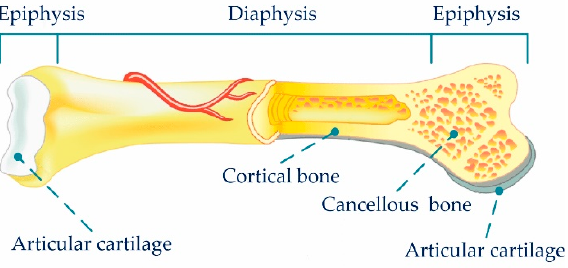
Figure 6. The anatomy of a long human bone.